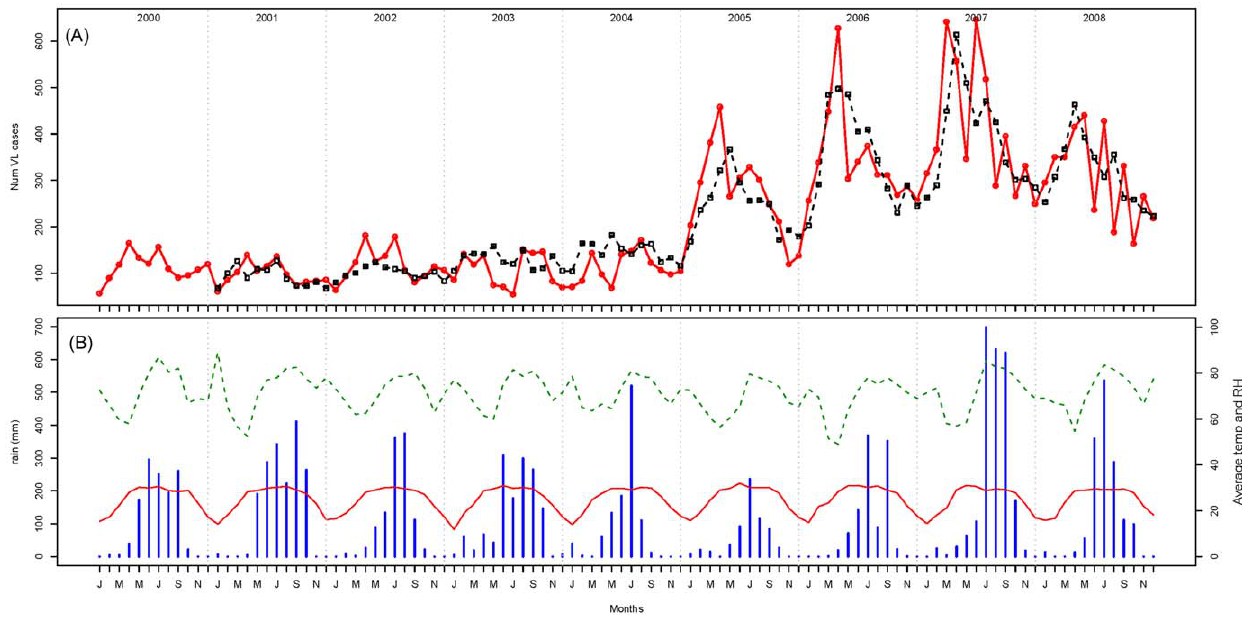
Figure 2. Observed and predicted VL cases and recorded meteorological parameters for each month from 2000 to 2008. (A) The observed (solid red line) and the predicted (dashed line – estimated from the negative binomial model) numbers of monthly Visceral Leishmaniasis (VL) cases in Muzaffarpur district from 2000 to 2008. (B) Monthly rainfall in mm (blue histogram), average temperature (temp) in u C (solid red line) and average relative humidity (RH) in % (dashed green line).